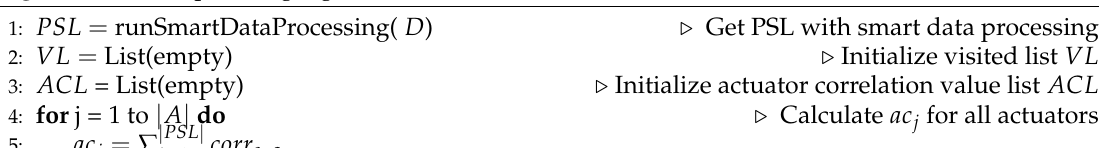
Algorithm 3 Path-planning algorithm in the actuator